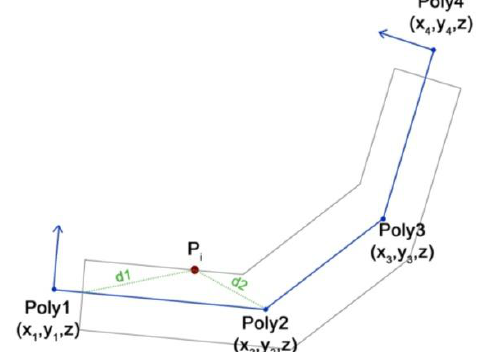
Figure 7. Plan of the projection on a broken vertical section plane: the cross section is in the middle line of a building.